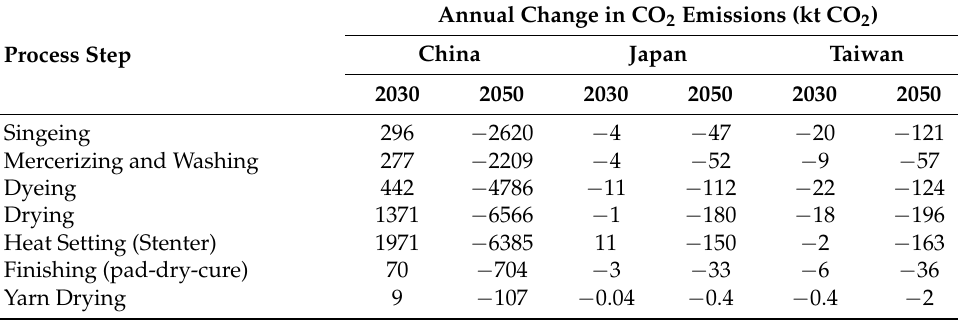
Table 8. Annual change in CO 2 emissions after electrification of the end-use